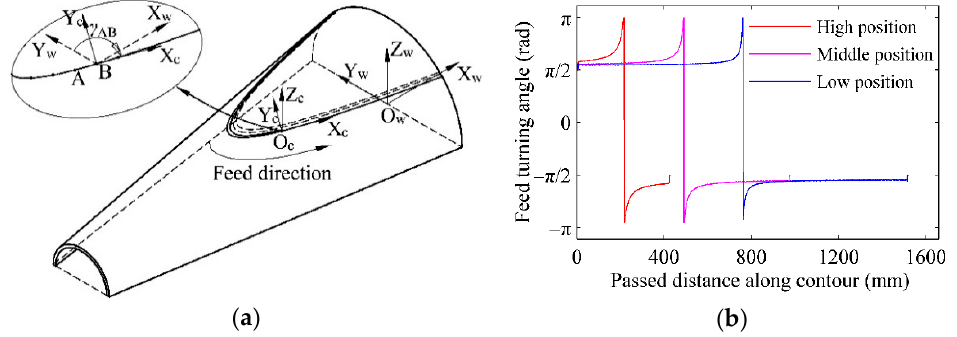
Figure 3. ( a ) Schematic diagram of the workpiece, contour tool path and coordinate system O c ‐ X c Y c Z c ; ( b ) simulation results of the feed turning angle along the contours from different heights.